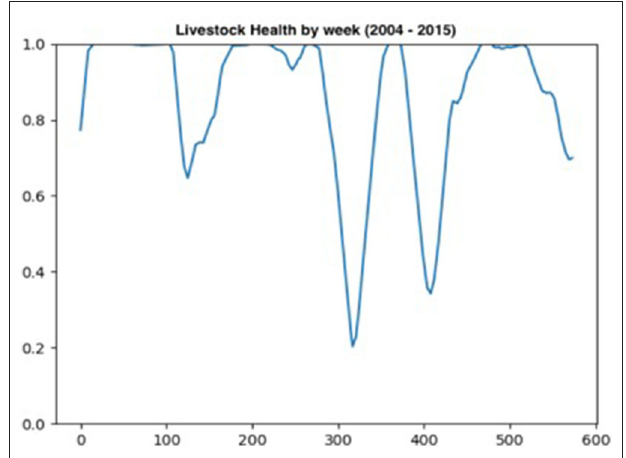
FIGURE 5 | Changes in Livestock health per week over 11.5 years.